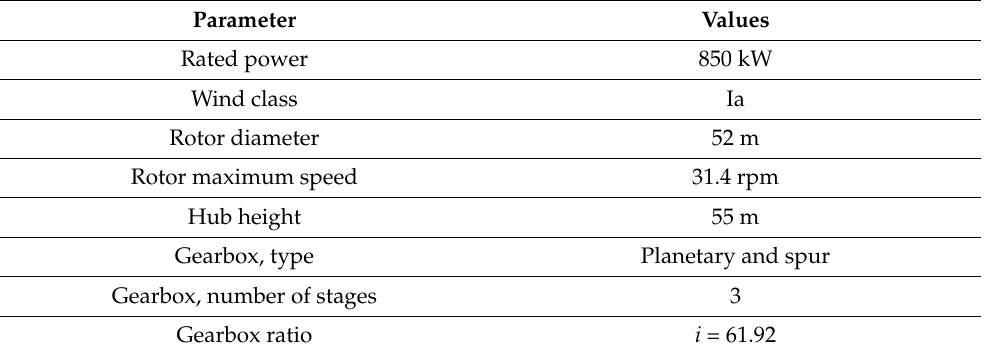
Table 2. Main Specifications of Vestas V52 WT